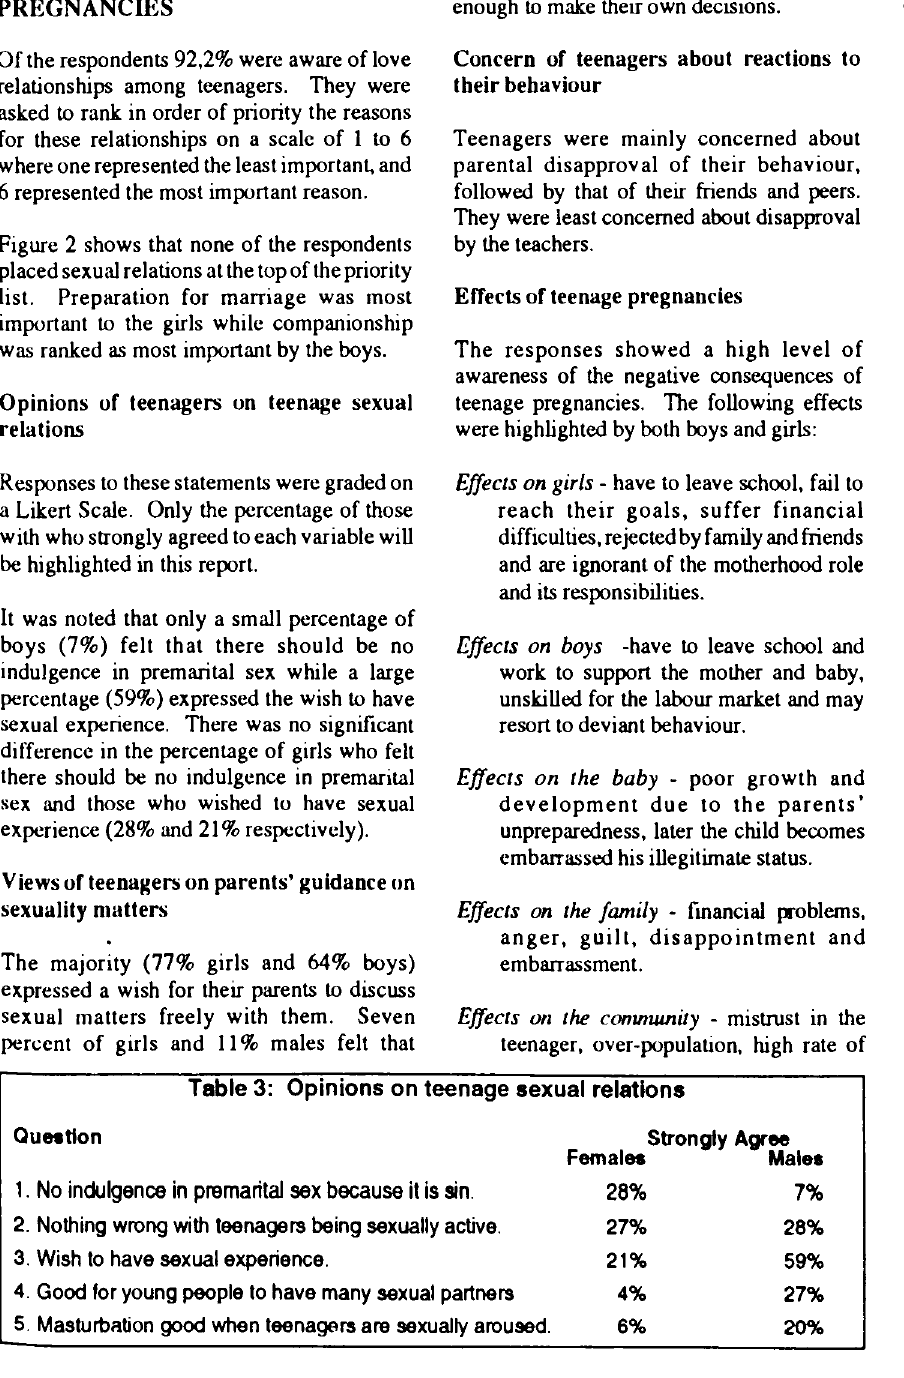
Figure 2: Rank order of reasons for teenage love relationships